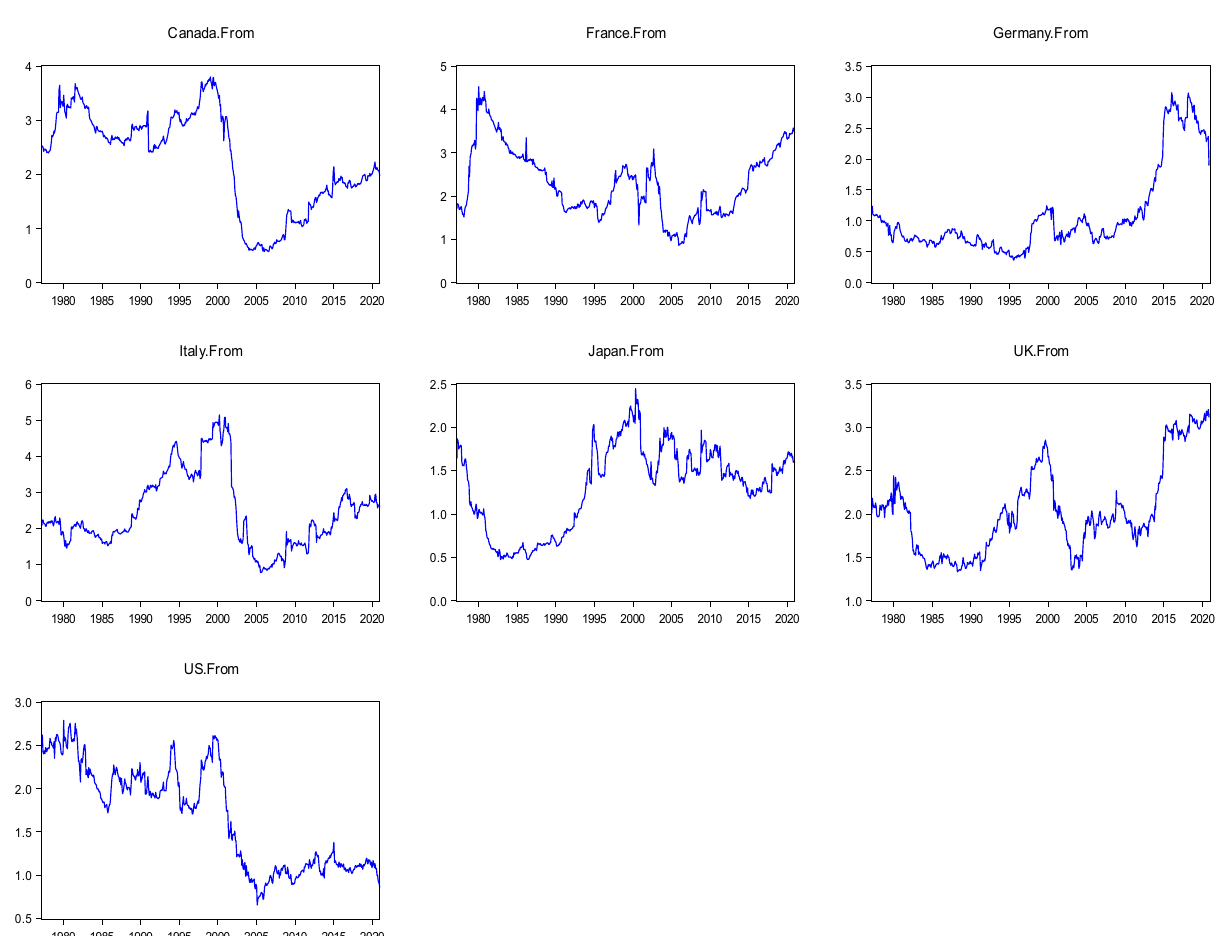
Figure 3. Inflation spillover in each of the G7 countries from other countries with the Diebold and Yilmaz (2012) methodology, 1956–2020.